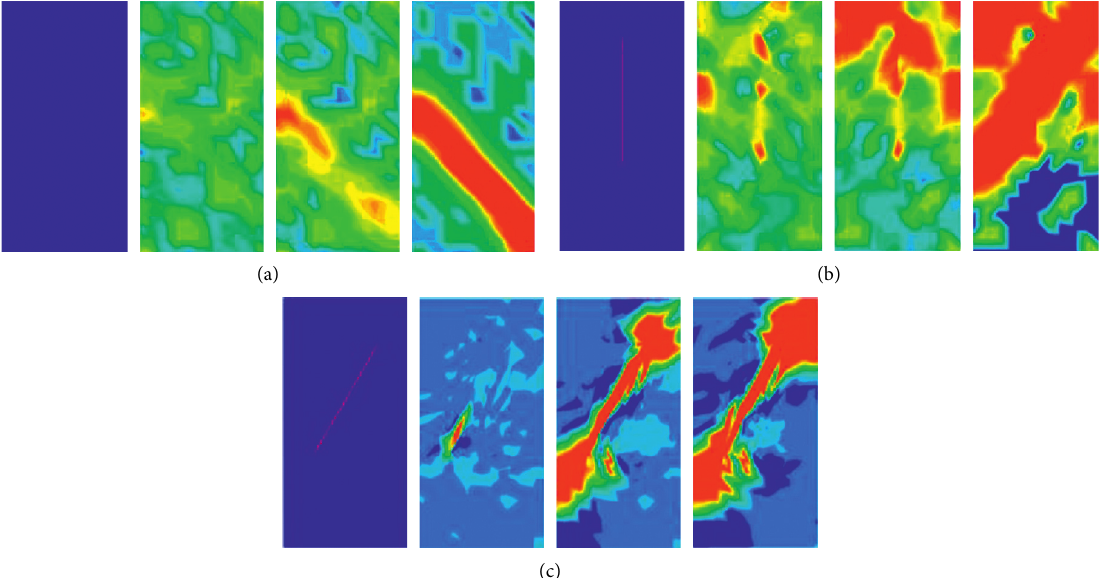
Figure 10: Numerically simulated crack evolution in specimens containing single crack with different preferential angles. (a) Intact specimens. (b) θ p � 90 ° . (c) θ p � 60 ° .